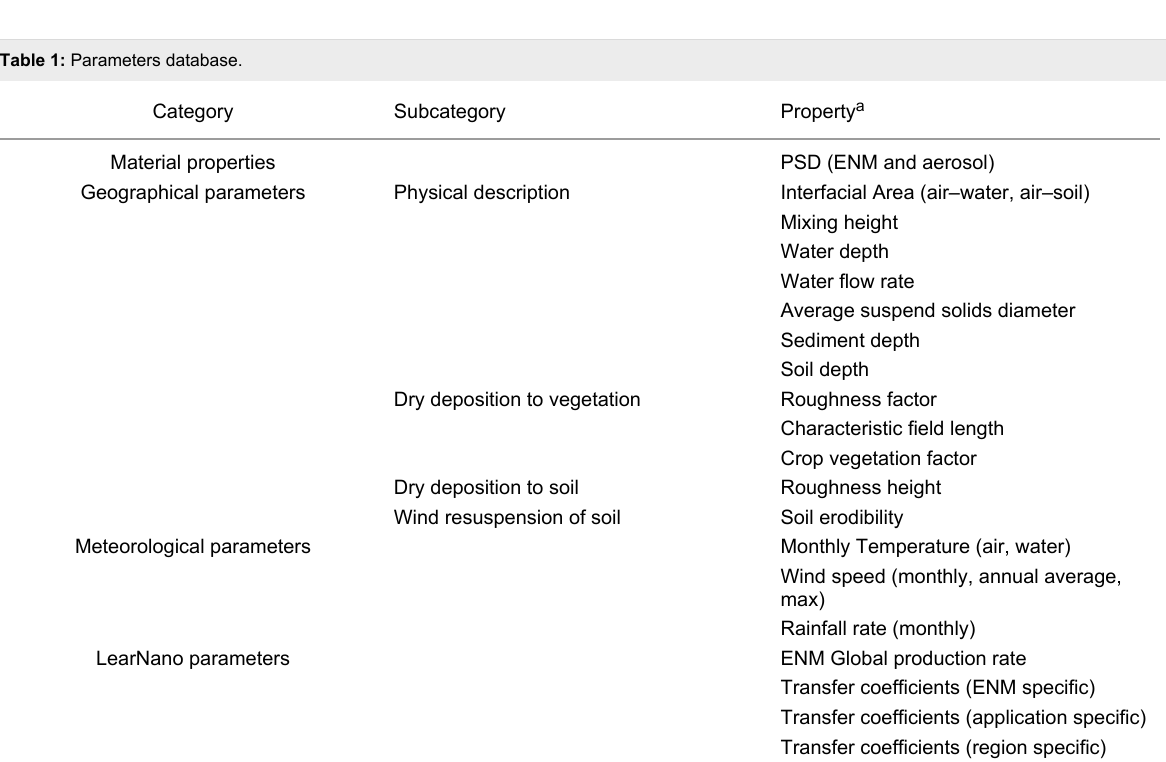
Figure 8: Examples of graphical representations of MendNano simulation results depicting concentration profiles and mass distributions of TiO 2 in the Los Angeles region among the various compartments and among the ambient particles in air. Release of TiO 2 in the above example is in air (5,000 kg yr − 1 ) and water (19,381 kg yr − 1 ).